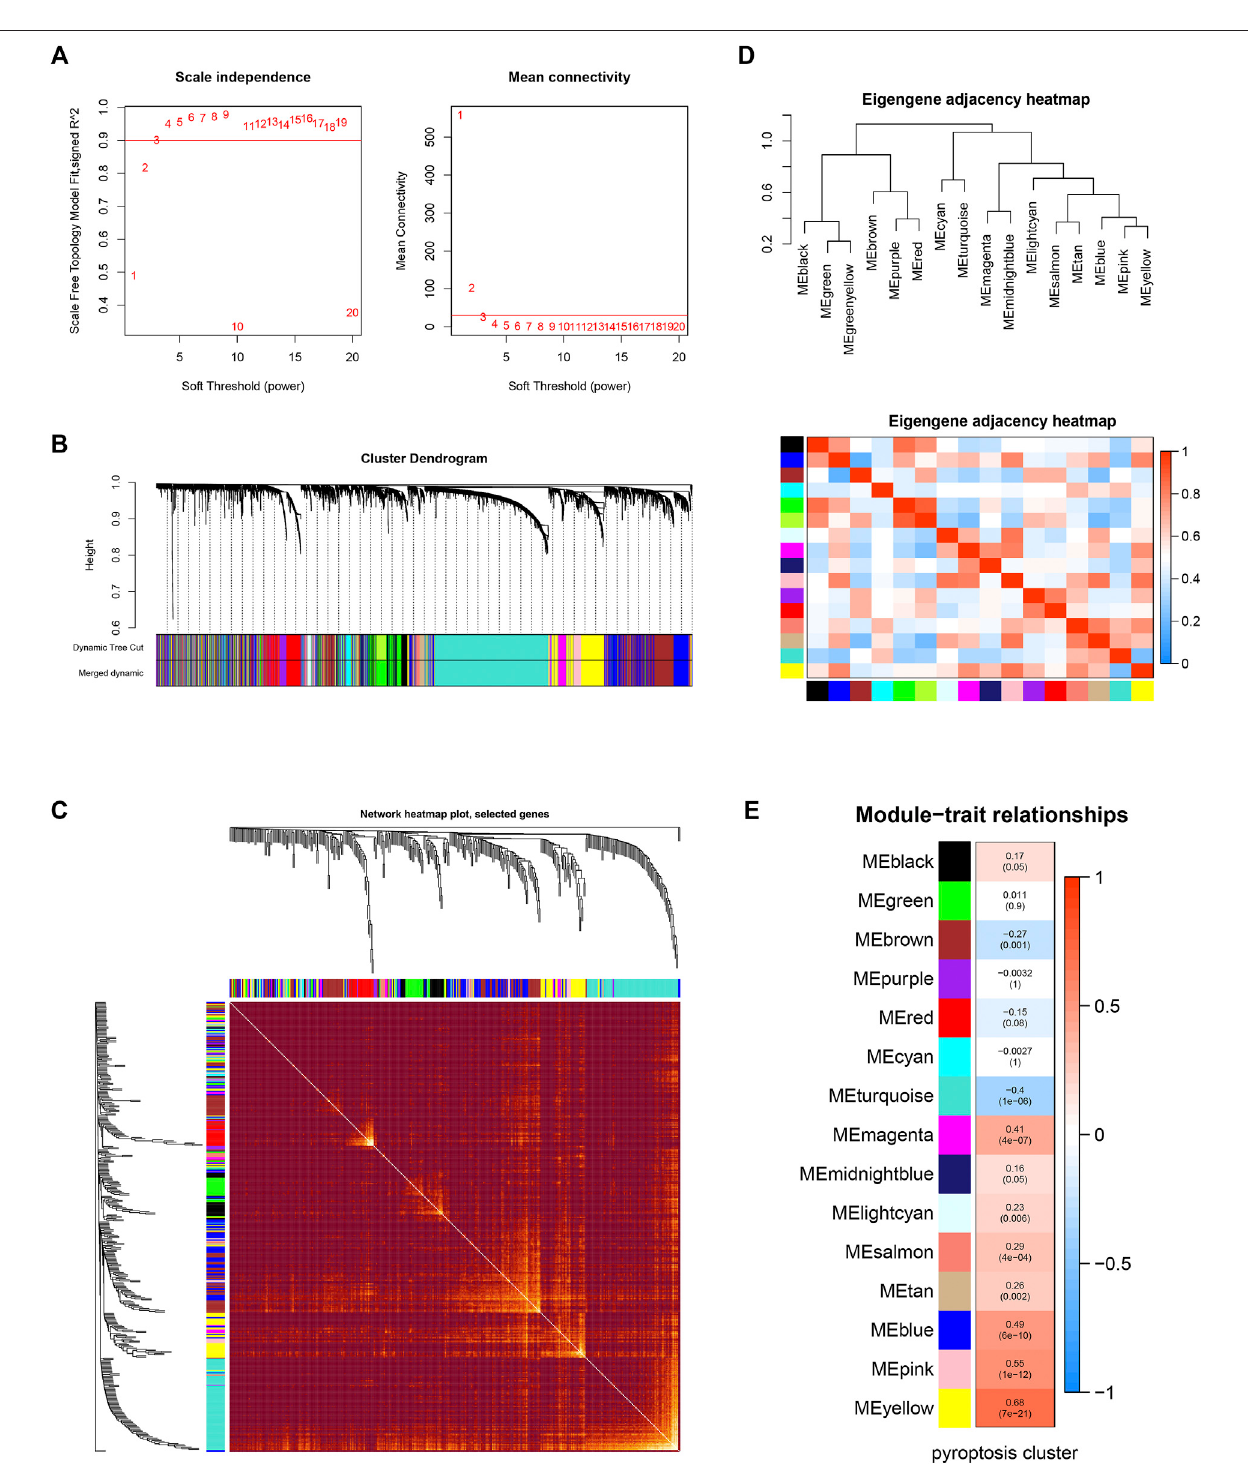
FIGURE 2 | Weighted gene coexpression network analysis. (A) Analysis of network topology for various soft-thresholding powers. The left panel shows the scale- free fi t index ( y -axis) as a function of the soft-thresholding power ( x -axis). The right panel displays the mean connectivity (degree, y -axis) as a function of the soft- thresholding power ( x -axis). (B) Clustering dendrogram of genes, with dissimilarity based on topological overlap, together with assigned module colors. (C) Visualizing the gene network using a heatmap plot. The heatmap depicts the Topological Overlap Matrix (TOM) among all genes in the analysis. Light color represents low overlapandtheprogressivelydarkerredcolorrepresentsahigheroverlap.Blocksofdarkercolorsalongthediagonalarethemodules. (D) Visualizationoftheeigengene networkrepresentingtherelationshipsamongthemodulesandtheclinicaltraitweight. (E) Module-trait associations:Each rowcorrespondstoamoduleeigengeneand the column to the pyroptosis cluster. Each cell contains the corresponding correlation and p -value.